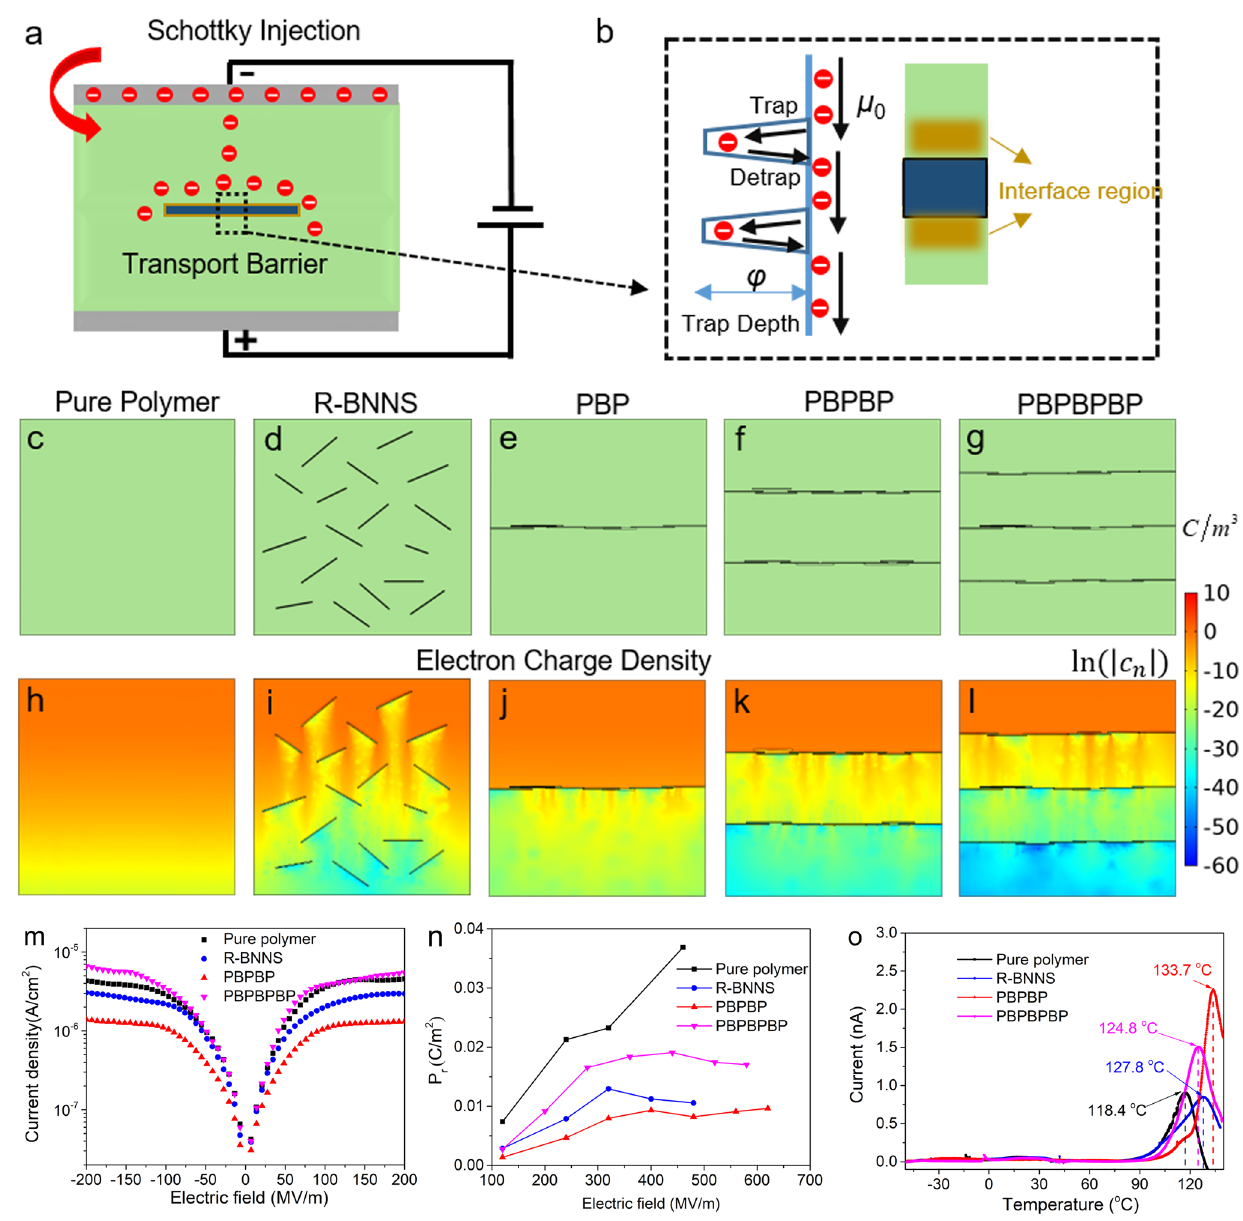
Fig. 1 Schematic illustration of a Schottky injection in BNNS polymer composite and b electron transportation at the filler/matrix interface with trapping and detrapping process, c pure polymer, d nanocomposite with randomly dispersed BNNS (R-BNNS), e nanocomposite with one BNNS layer (PBP), f nanocomposite with two BNNS layers (PBPBP), g nanocomposite with three BNNS layers (PBPBPBP). Simulation results of the electron charge density distributions ( t = 1 s) of h pure polymer, i nanocomposite with randomly dispersed BNNS, j nanocomposite with one BNNS layer, k nanocomposite with two BNNS layers, l nanocomposite with three BNNS layers, under the DC electric field of 300 MV m −1 and the temperature of 298 K. Comparison of m current density, n remnant polarization, and o TSDC results of PVDF, nanocomposite with ran- domly dispersed BNNS (R-BNNS), nanocomposite with two BNNS layers (PBPBP) and nanocomposite with three BNNS layers (PBPBPBP) in